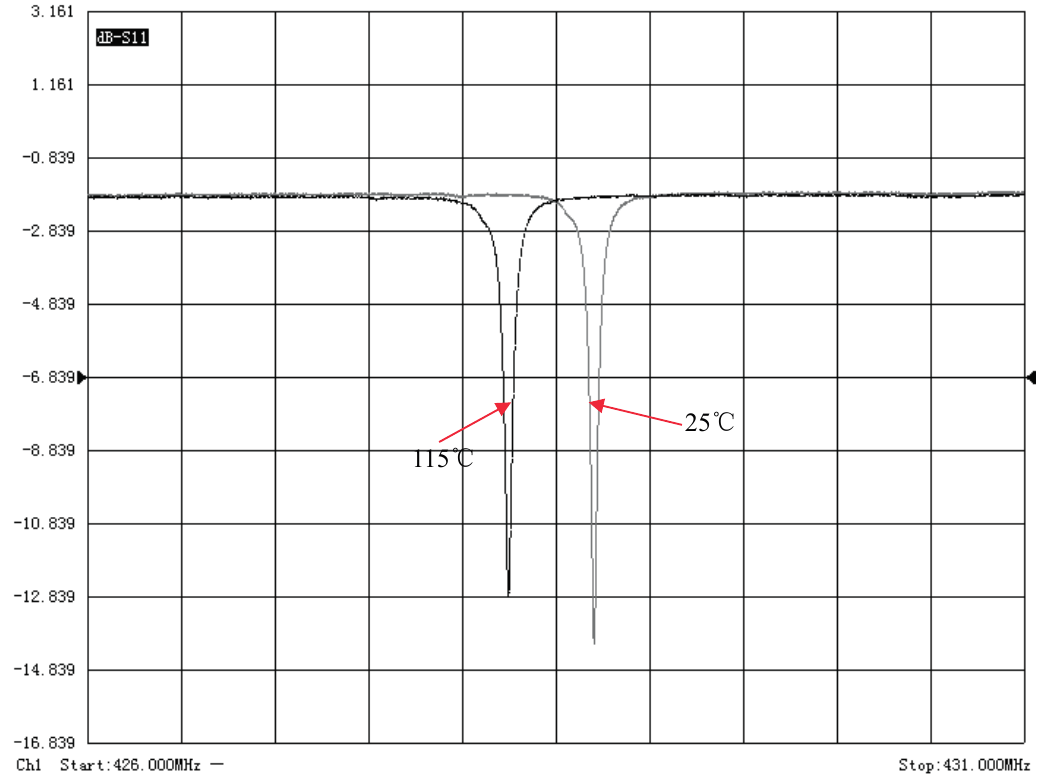
Figure 7. The measured reflection coefficient (S 11 ) of a resonator at 25 °C and 115 °C, respectively.